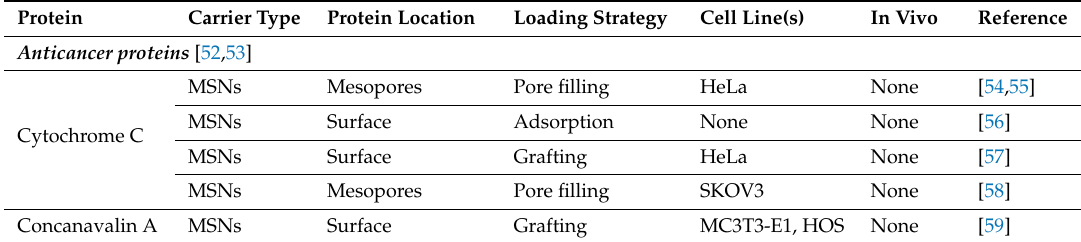
Table 1. Examples of therapeutic proteins delivered by silica-based